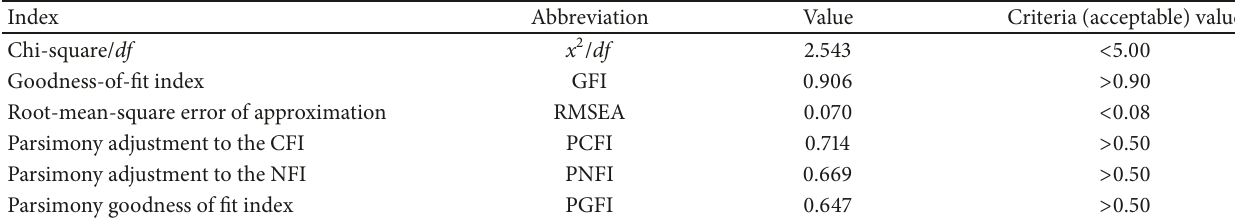
Table 3: Model fitness index for the hypothesized and alternative